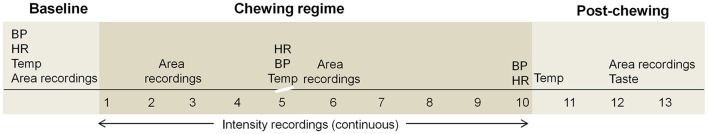
An overview of the experimental session shows all measures prior to, during and following the standardized 10 min chewing regime. A short (15–20 s) interruption in chewing is indicated by the scale break. BP, blood pressure; HR, heart rate; Temp, intra-oral temperature; Taste, taste experience questionnaire.